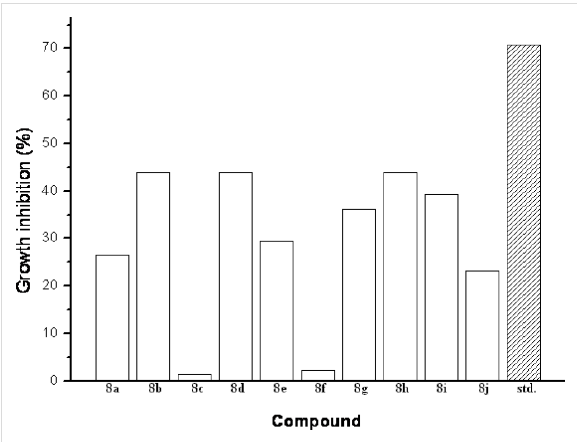
Figure 3: Growth inhibition of Bacillus subtilis by compounds 8a–j at 1 µM (15 h), and standard erythromycin at 1 µM (15 h).